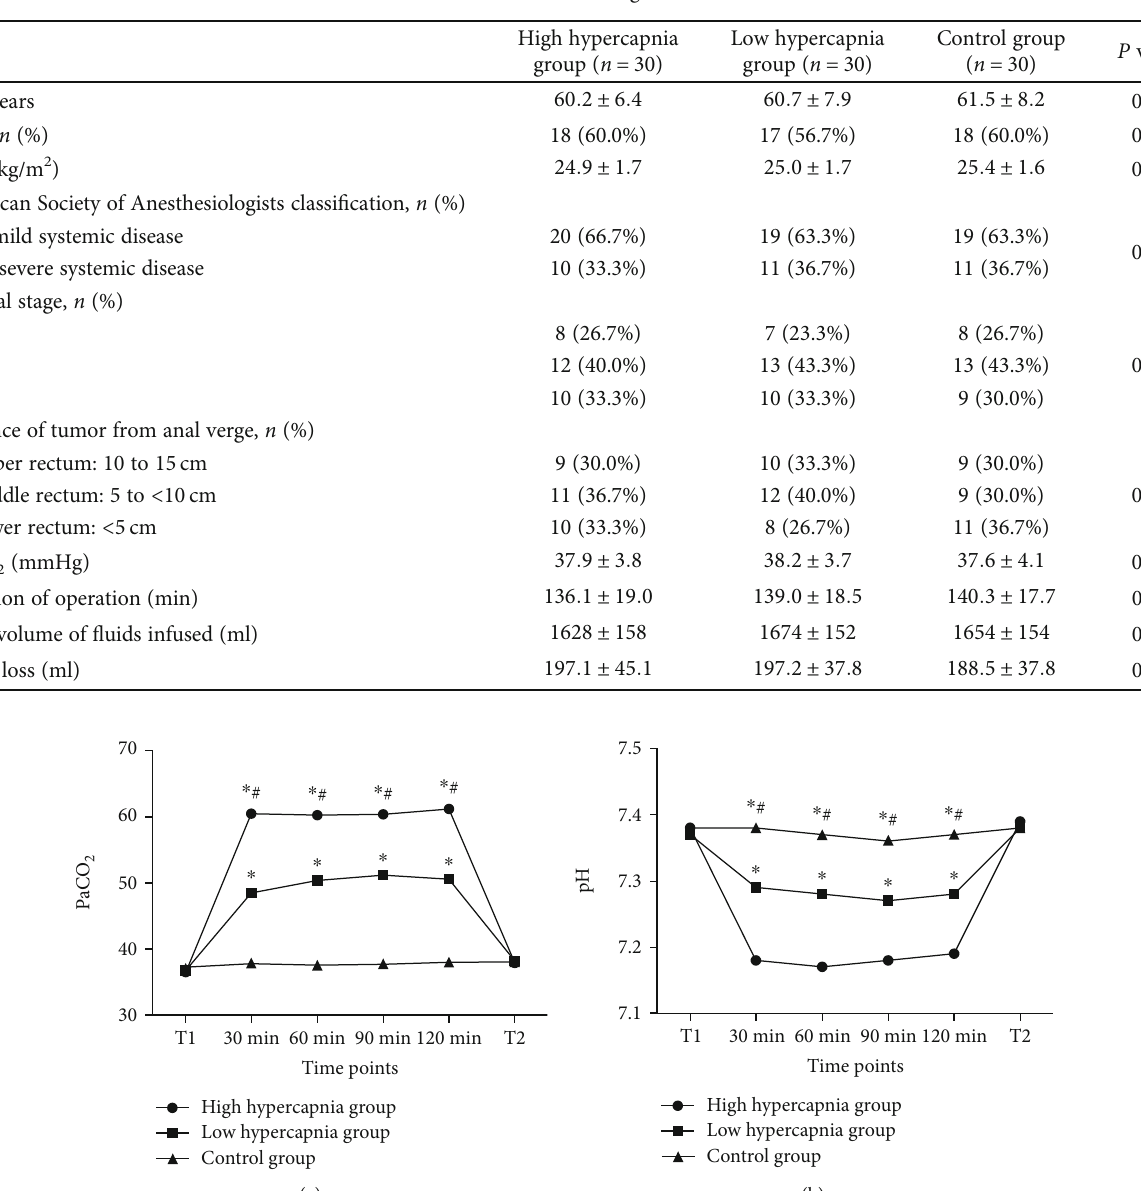
Table 1: Patients ’ baseline and surgical characteristics.